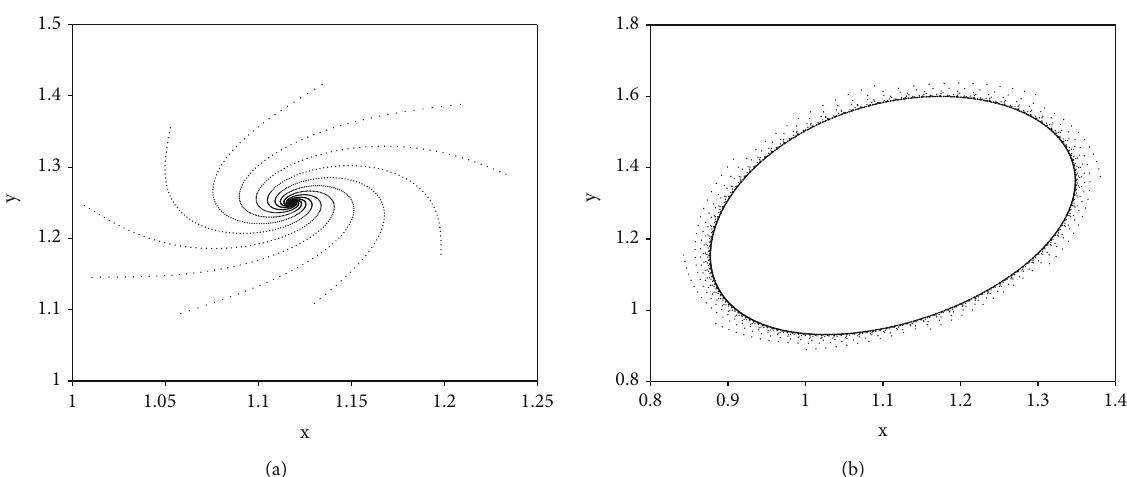
Figure 5: Phase diagrams of map (10) for q = 0 : 95 . (a) δ = 0 : 46 . (b) δ = 0 : 47 .